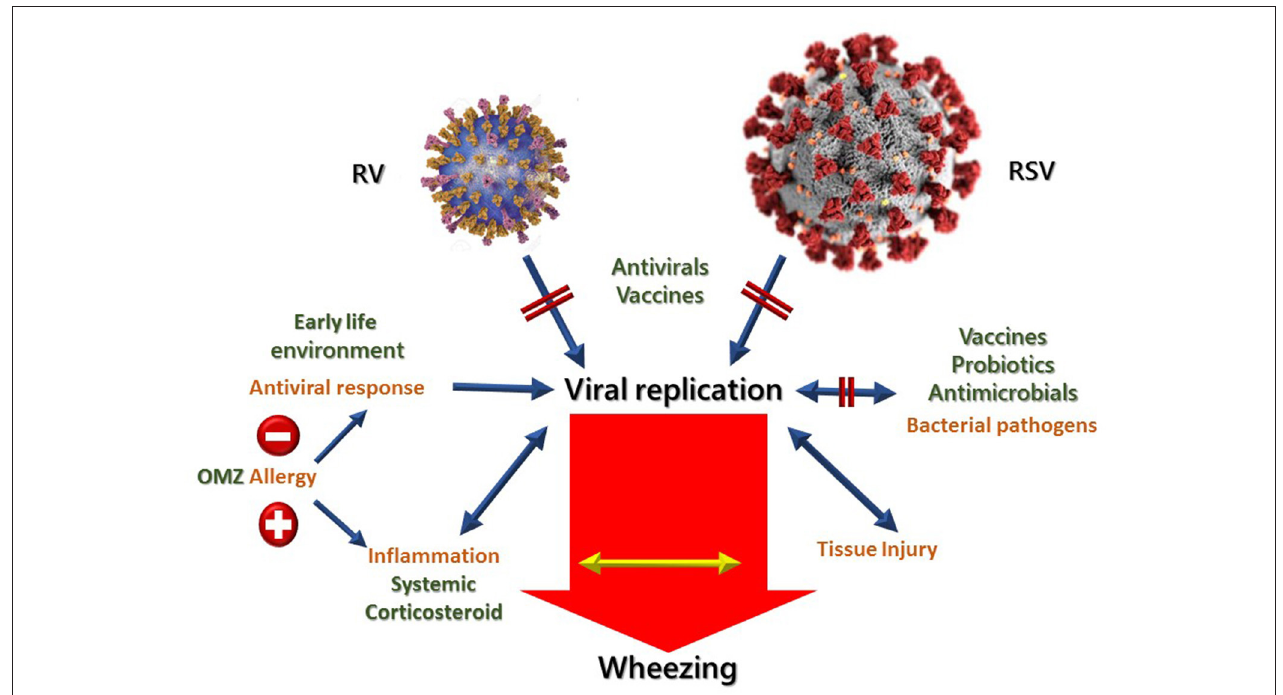
FIGURE 2 | Possibilities of treating and preventing viral induced wheezing diseases. Opportunities for intervention are marked in red. OMZ, Omalizumab. Adapted from Jartti et al.